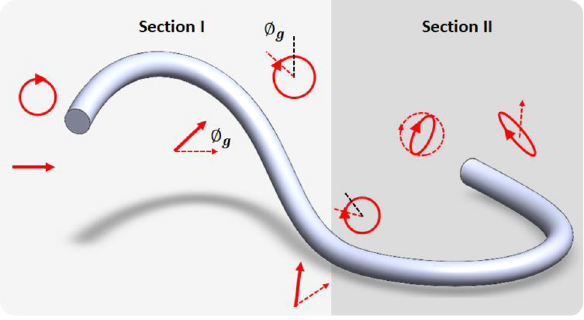
Figure 4: The effect of nonplanar and birefringent perturbations on the polarization of light launched into single-mode fibers (SMFs), illustrated as a flexed gray cylinder. Solid red arrows represent linear polarization states of light in the fiber at different positions along the propagation direction, with the dashed arrows denoting the state it possessed just before propagating to that